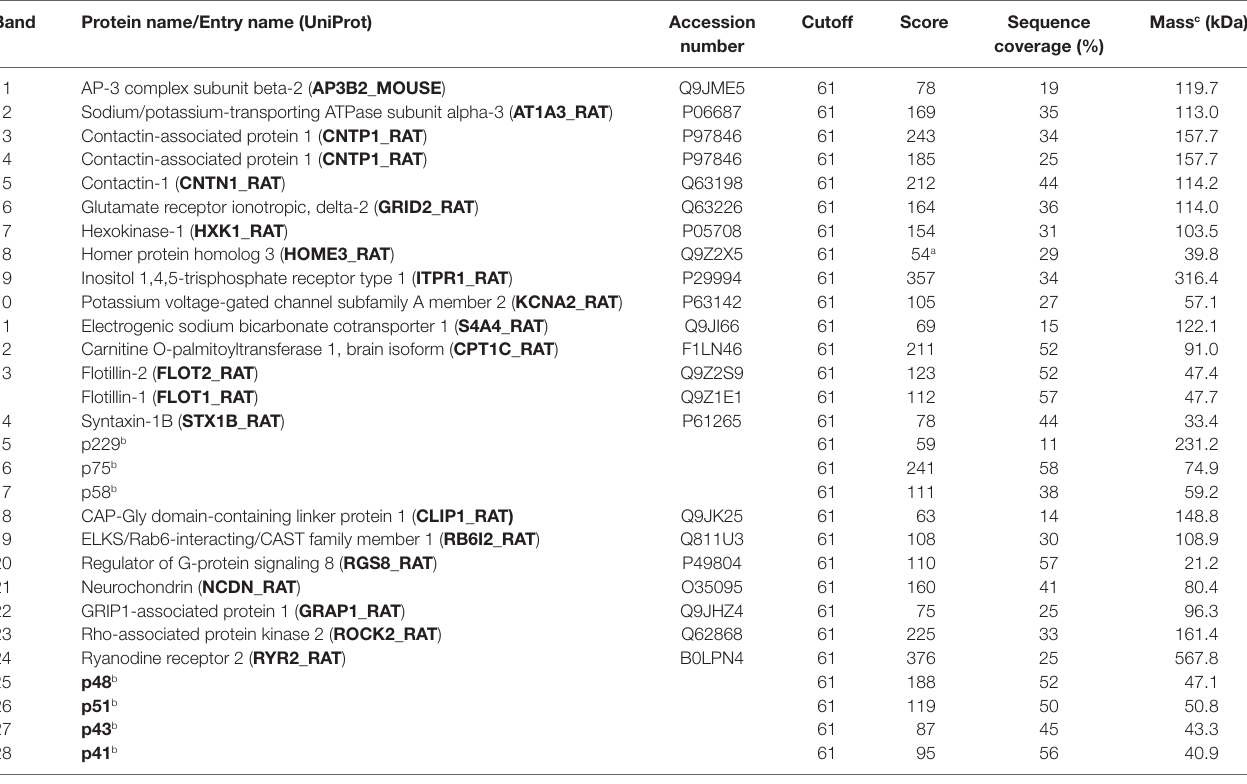
TaBle 1 | Proteins identified from immunoprecipitates using matrix-assisted laser desorption/ionization–time of flight mass spectrometry by peptide mass fingerprinting. Band Protein name/entry name